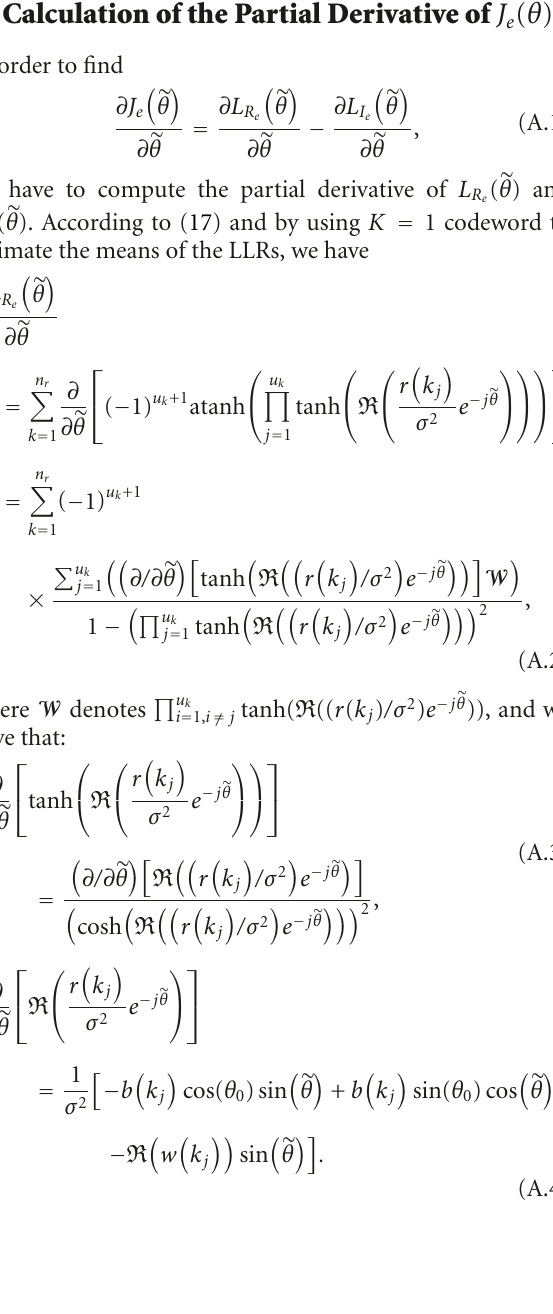
Table 1: Complexity in terms of number of multiplications for di ff erent algorithms presented in this paper. Algorithm Complexity HDD algorithm for phase estimation O ( N ) Phase estimation technique of [24, 25] Phase estimation technique of [26] Proposed phase estimation technique Classical CFO estimation technique NLLS algorithm for CFO estimation Proposed CFO estimation